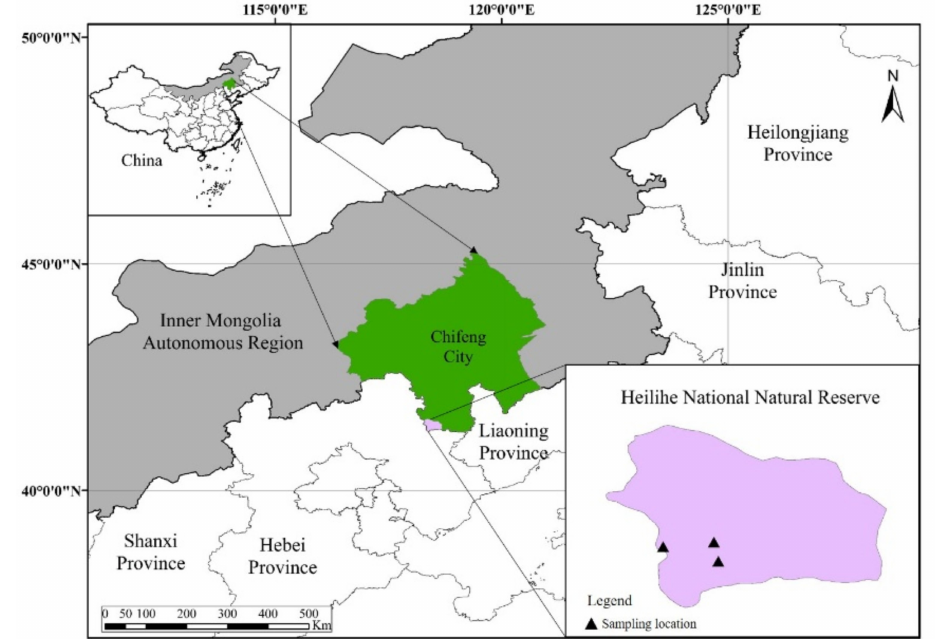
Figure 2. Sampling locations in Heilihe National Natural Reserve.